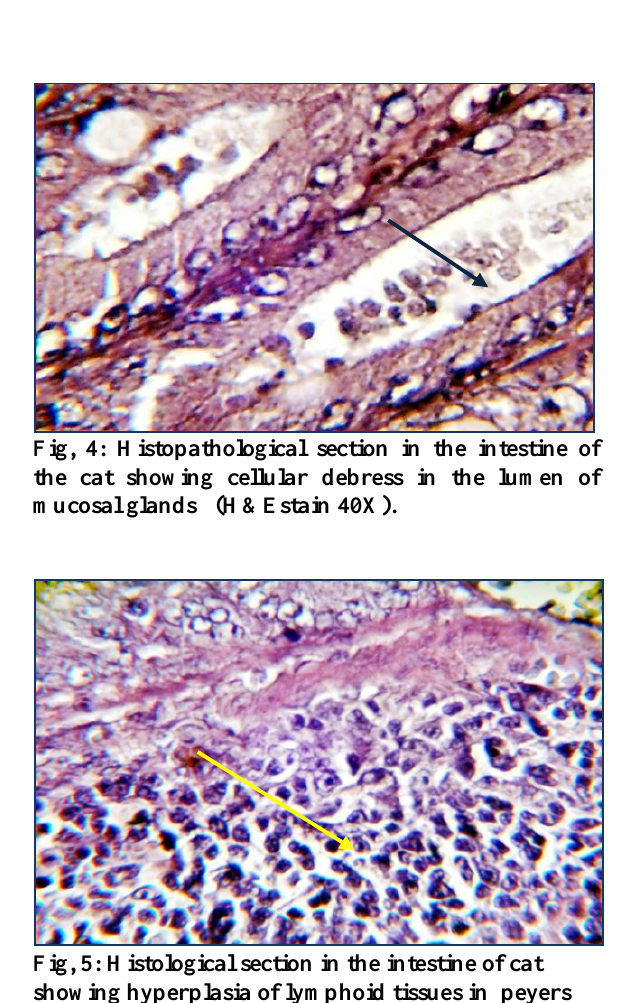
Fig, 3: Histopathological section in the brain of cat showing congestion of blood vessels of meninges with neutrophils in their lumen in pia mater (H&Estain 40X).